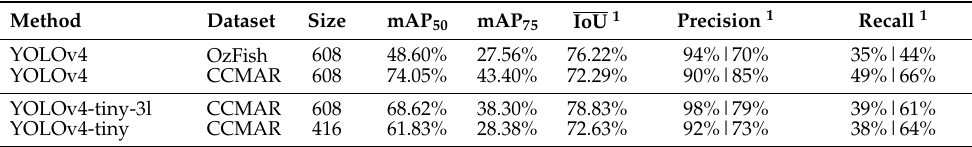
Table 2. Results obtained from testing the models with the marine biologist-annotated images from different locations. Method Dataset Size mAP 50 mAP 75 IoU 1 Precision 1 Recall